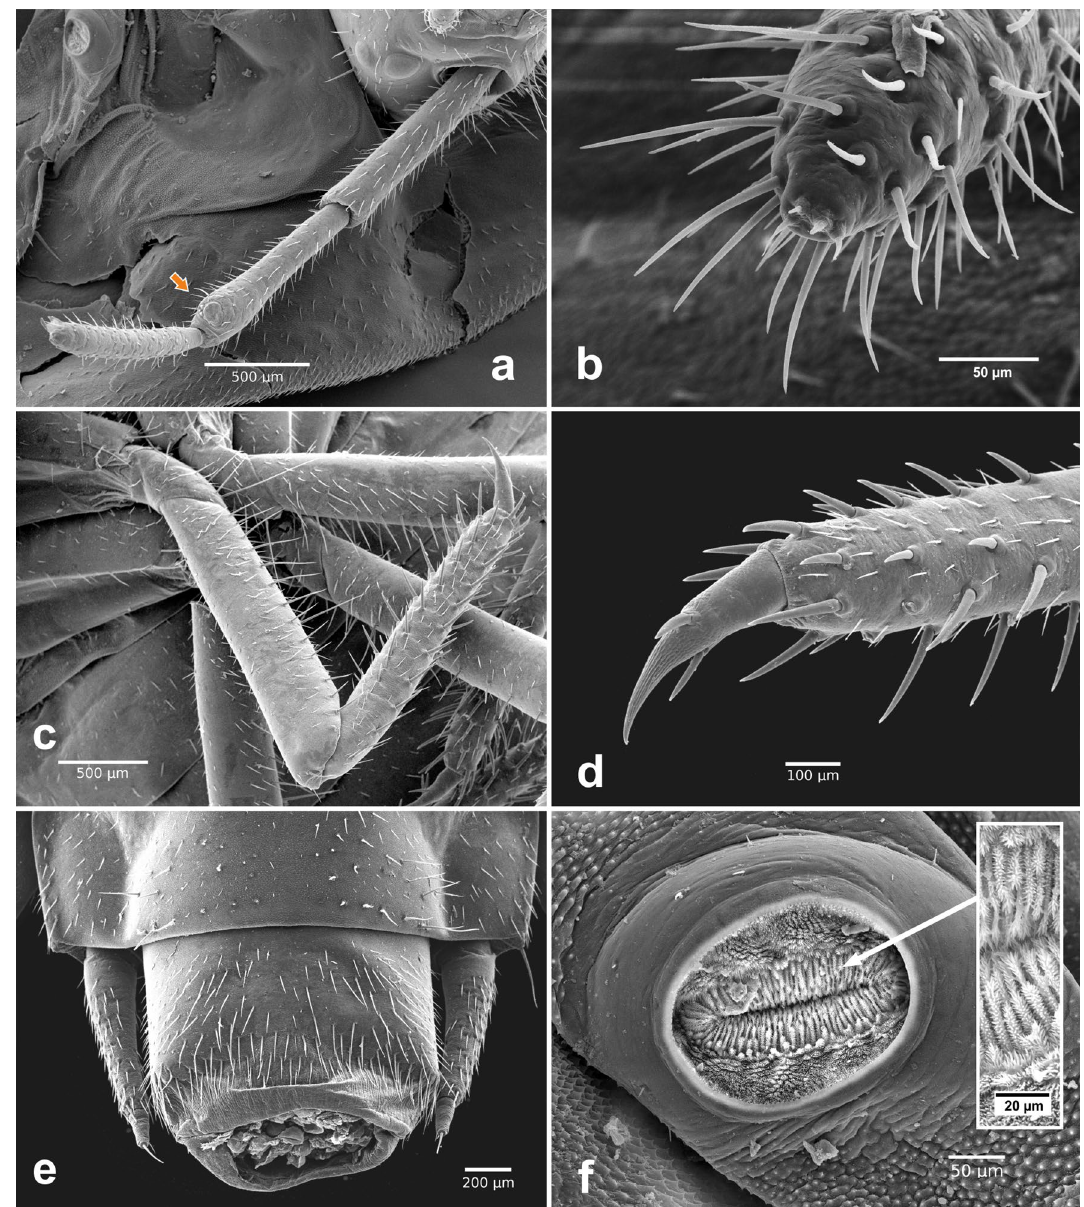
Figure 5. Heterotemna tenuicornis (Brullé, 1836), details of external morphology of larva, SEM: ( a ) antenna, dorsal view; ( b ) apex of antennomere III, dorso-apical view; ( c ) proleg, lateral view; ( d ) tibiotarsus and pretarsus, lateral view; ( e ) tergites IX–X and urogomphi, dorsal view; ( f ) mesosternal spiraculum in lateral view; inset—detail of multi-branched filtration hairs, ( a , c – f ) third instar, ( b ) first (Fig. 3a, b). Instar II. Pair of lighter subcircular translucent spots on protergum not clearly delimited (Fig. 3f–g). Mean total body length: 15.55 mm ± 1.16 mm. Instar I. Two lighter subcircular spots present on protergum more apparent, well-delimited (Fig. 3d–e). Mean total body length: 13.02 mm ± 0.77 mm. Head capsule Instar III. Prognathous. Head capsule covered dorsally and laterally by regular, densely arranged erected setation (Fig. 6a–c). Longest setae present on anterior and anterolateral part of frons (Fig. 6d–e). Cranium with isodiametric microsculpture, latero-posteriorly with paler spots (Fig. 6g). Epicranial stem (= coronal suture) present (Fig. 6a, es), V-shaped frontal arms (= frontal sutures) passing into U-shaped base in one third of their length (Fig. 6e, fa). Short median desclerotized line extending beyond epicranial stem (Fig. 6e, ml). Six stemmata on both sides of the head organized into two groups – four forming sub-rhomboid pattern placed dorsally behind antennal socket (Fig. 6e), and two ventro-laterally behind the antennal socket (Figs. 5a, 6c). Frontoclypeal suture absent, rudiments present only laterally as distinctly sclerotized, transverse, extension of anterior tentorial pits (Fig. 6d, atp). Clypeus trapezoidal; anterior margin distinctly sclerotized, widely emarginate and only narrowly desclerotized medially (Fig. 6b, d). Epipharynx, with the exception of medial part, covered by densely arranged microtrichia oriented posteriorly and medially (Fig. 7b). Anterolaterally, the heavily sclerotized epipharyngeal